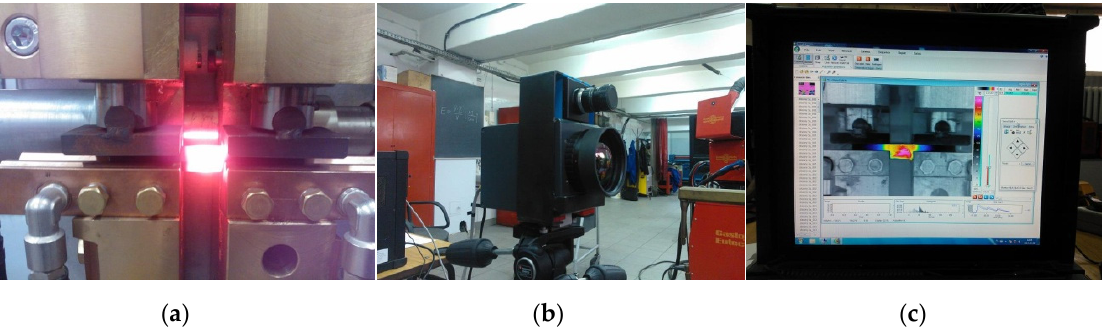
Figure 2. Test stand for simulation and recording of thermal welding cycles: ( a ) resistance welding machine, ( b ) thermal imaging camera, ( c ) computer station screen.